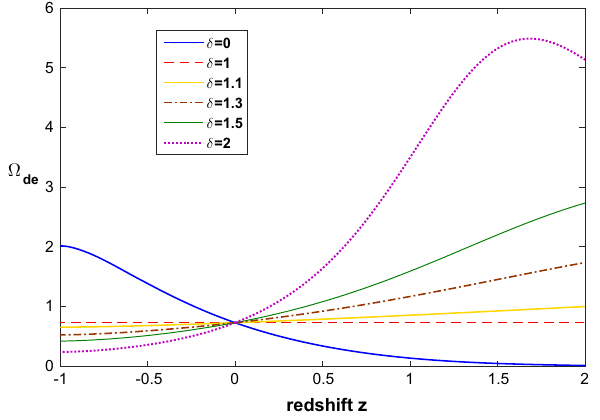
Fig. 2 Plot of EoS parameter of non-interacting THDE model versus redshift z for β 1 = 7 . 1, β 2 = 2 . 15, w = 1000, Ω 0 = 0 . 73 and u = 0 . 3 de